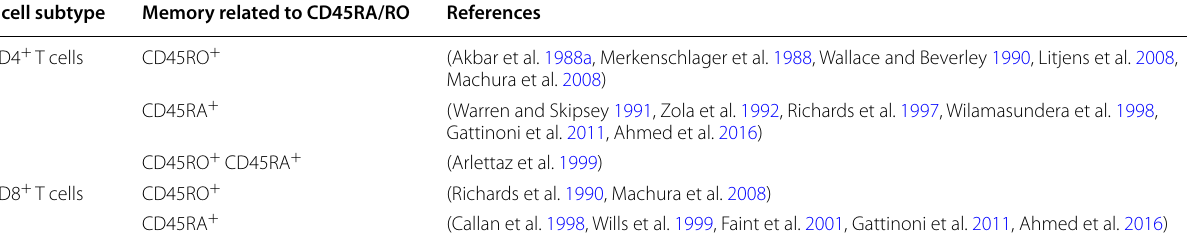
Table 1 CD45RA/RO expression on the human memory T